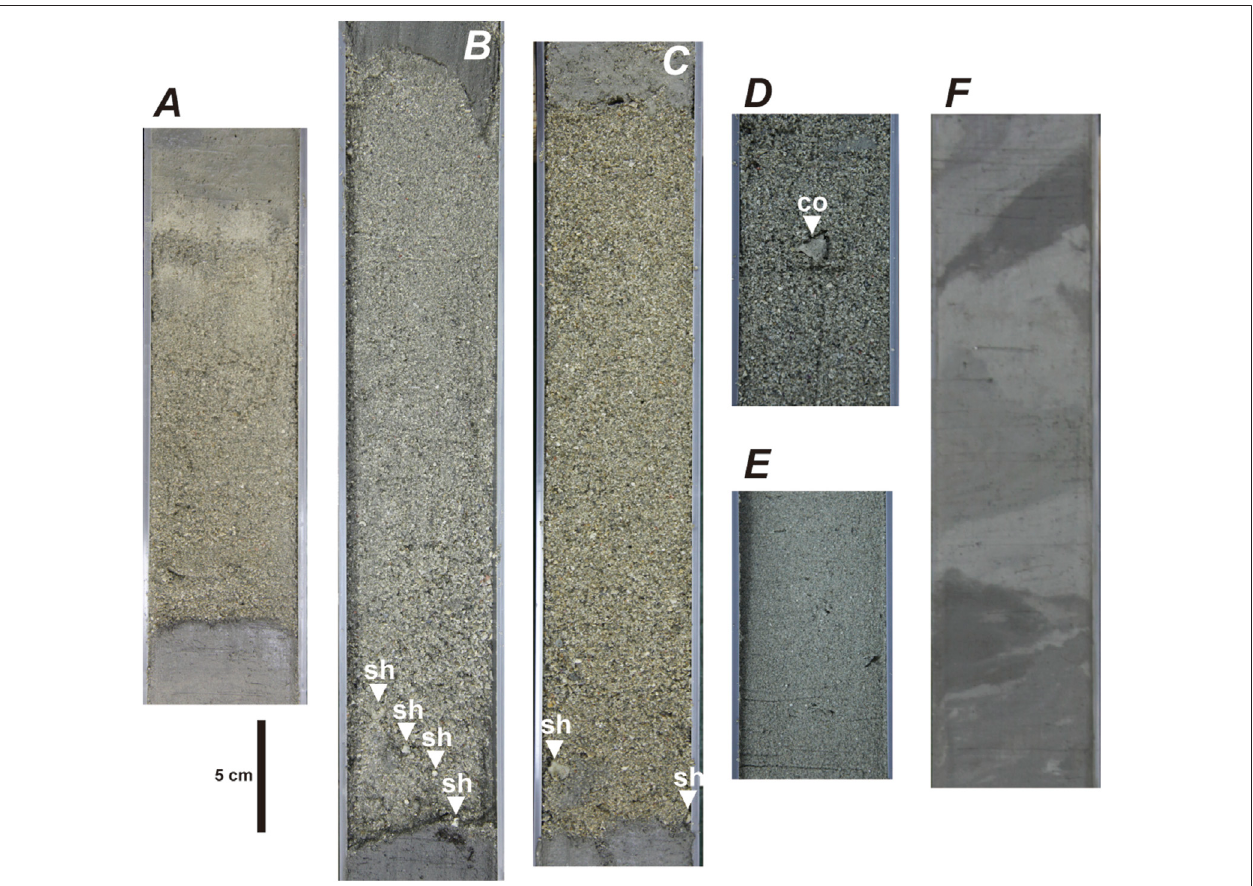
FIGURE 5 | Typical examples of calciturbidite (A – E) and chaotic mass-transported deposit facies (F) in the obtained cores. (A) fi ning-upward calcareous medium – very fi ne sand witha sharpbase (core YK15PC01 at 100.2 – 126.2 cm), (B) fi ning-upward calcareous coarse – fi ne sand witha sharp base(core YK15 PC08